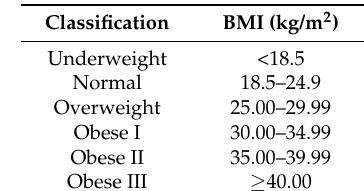
Table 2. The international classification of adult underweight, overweight, and obesity according to BMI. Source: Adapted from WHO, 1995, WHO, 2000, and WHO, 2004.